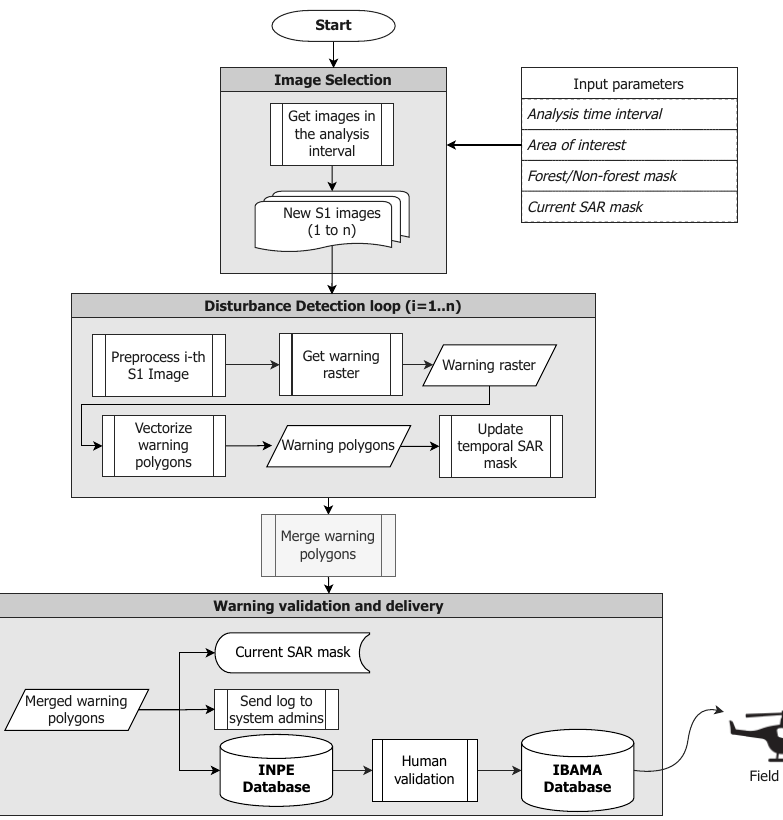
Figure 3. Flowchart depicting the daily operational routine of the DETER-R